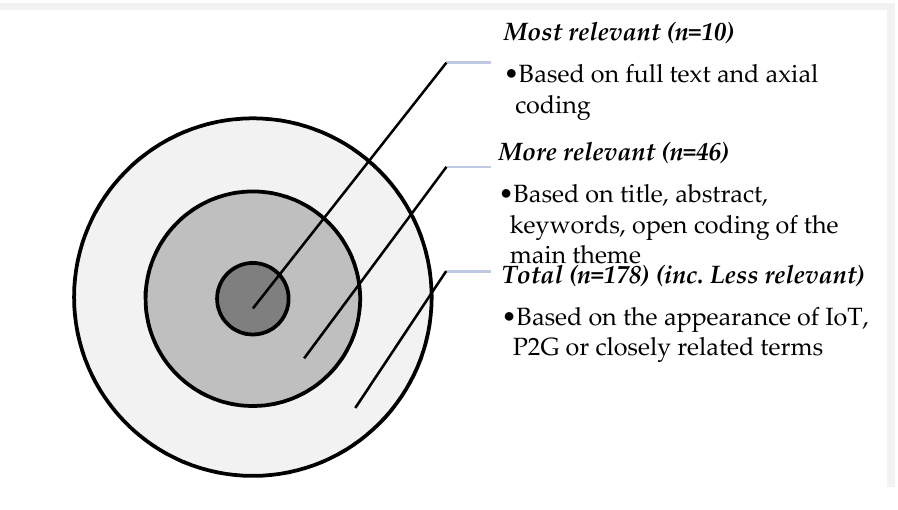
Figure 1. Results of relevancy assessment (own construction).